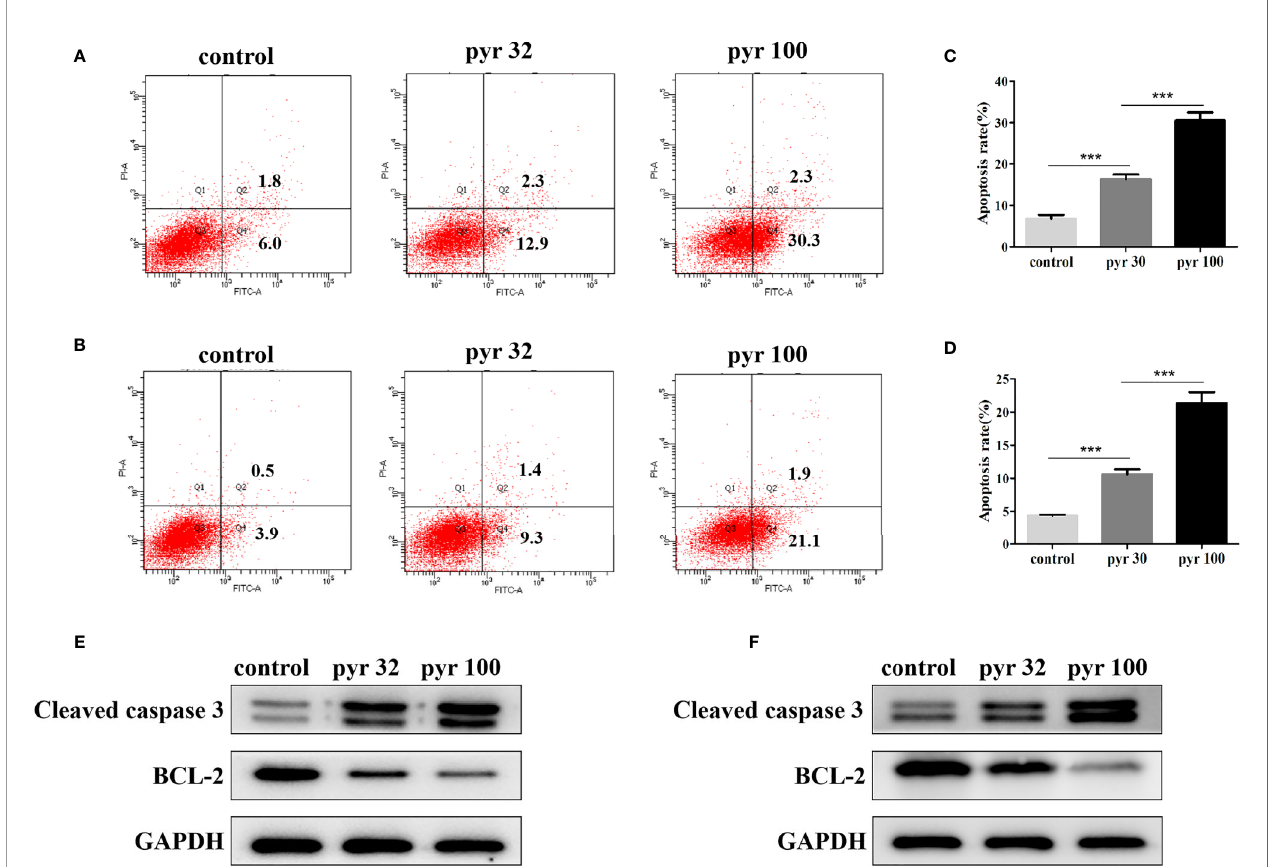
FIGURE 4 | Pyrimethamine promotes the apoptosis of CRPC cell lines. (A, B) Pyrimethamine promotes the apoptosis of DU145 (A) and PC3 (B) cells, which were analyzed by fl ow cytometric using Annexin V-FITC/PI staining. (C, D) Statistical results were represented as mean ± SD of three independent experiments. *** P < 0.001. (E, F) The expression of Bcl-2, caspase-3 was identi fi ed by western blotting after treating with 0, 32, and 100 m M pyrimethamine for 24 h (DU145 and PC3). GAPDH was used as a loading